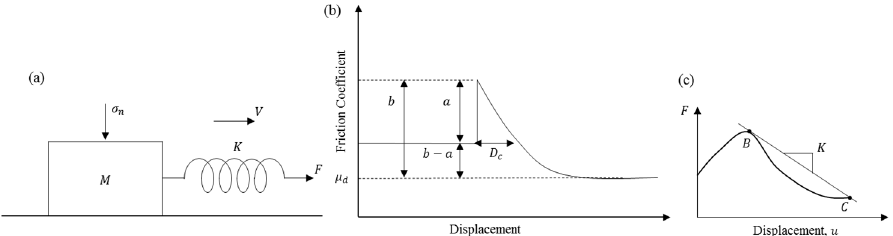
Figure 5. Schematic diagram showing the definition of the spring system and rate and state friction law. ( a ) The spring system, where σ n is the normal stress, K is the stiffness of spring, F is the loading force, V is the slip rate and M is the mass of system. ( b ) The rate and state friction law. µ d is the experimentally measured dynamic friction coefficient. ( c ) Force-displacement diagram in the vicinity of the fracture.